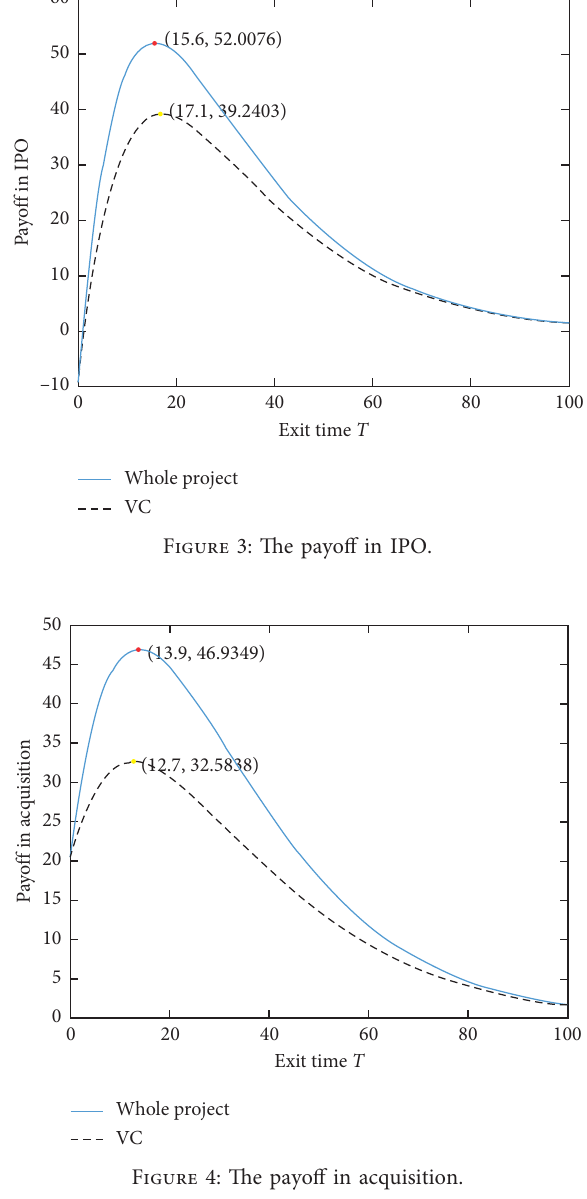
Figure 4: The payoff in acquisition.